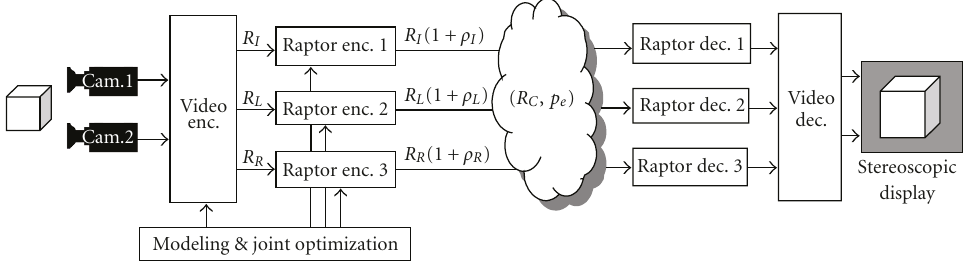
Figure 1: Overview of the stereoscopic streaming